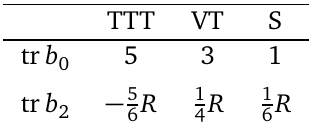
Table 1: Heat kernel coefficients for transverse traceless tensors (TTT), transverse vectors (VT) and scalars (S) on S 4